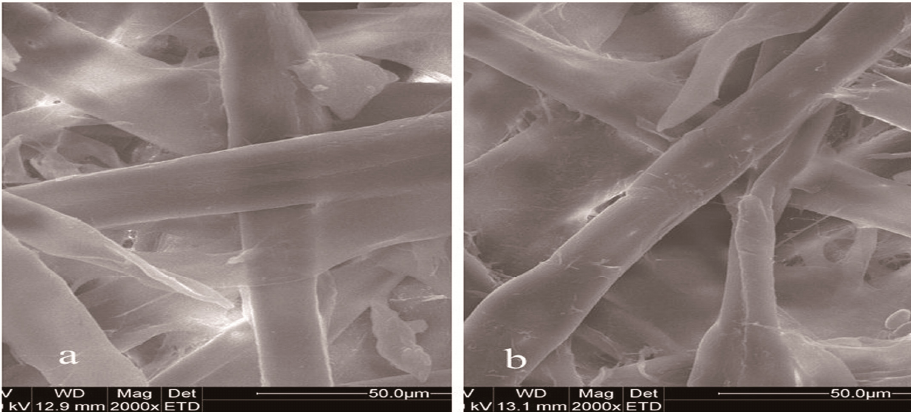
Figure 4. SEM of hand sheets of alkaline peroxide mechanical pulp (APMP) pulp/chemical pulp (1:1) without additives ( a ) and with the addition of CAX ( b ).